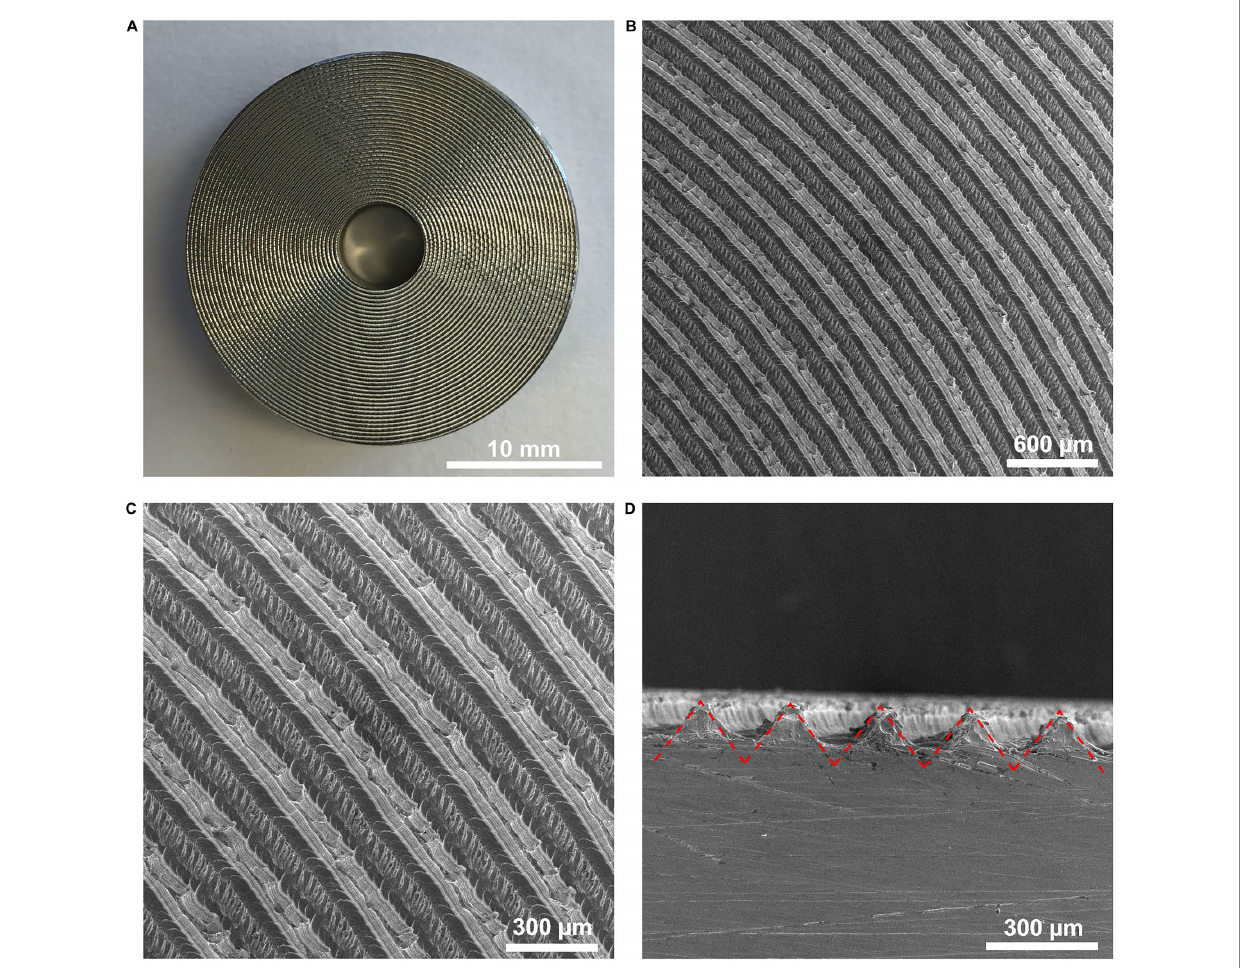
FIGURE 5 Ti alloy sample with engraved triangular surface structure. (A) Macroscopic top-view of the sample. One can see the triangular surface structure engraved in a spiral shape and the 5 mm borehole necessary for peel-off force measurement in the center of the sample. (B,C) Microscopic SEM top- view of the Ti alloy sample. (D) Cross section of the surface-structured Ti alloy sample with the triangular surface structure marked in red. One can see the periodic surface geometry with a tip spacing of about 250 µm and a depth of about 200